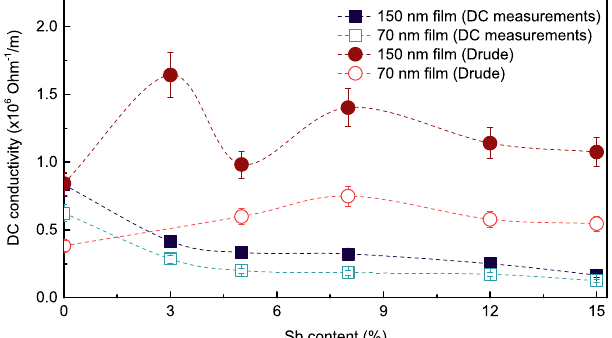
Figure 7. Comparison of DC conductivity for 150 nm and 70 nm Bi 1 − x Sb x films (on mica substrate) directly measured in DC configuration and extracted from THz measurements using Drude